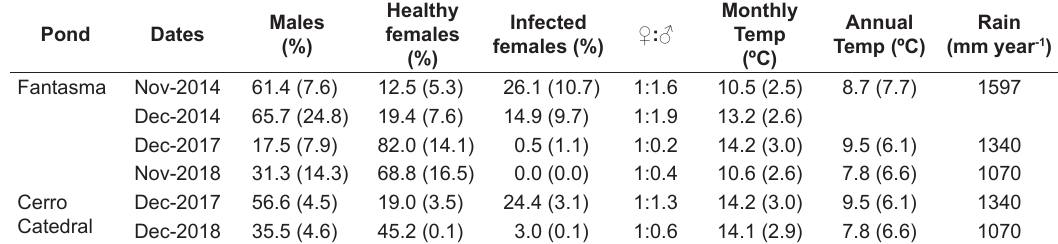
Table 2. Sex ratios and parasite prevalence in Parabroteas sarsi populations. References: Temp: Air temperature. Data are shown as mean (standard